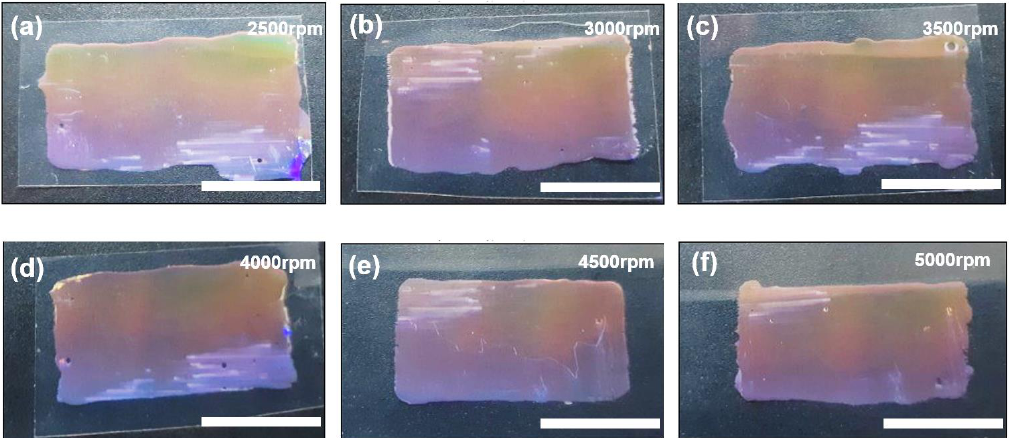
Figure 3. Pictures of the tiles, changing the speed of the spin coating: ( a ) 2500 × rpm, ( b ) 3000 × rpm, ( c ) 3500 × rpm, ( d ) 4000 × rpm, ( e ) 4500 × rpm, and ( f ) 5000 × rpm. The scale bars represent 1 cm.